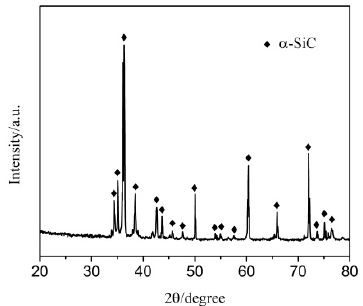
Figure 1. XRD pattern of the SiC coated C/C sample before oxidation.